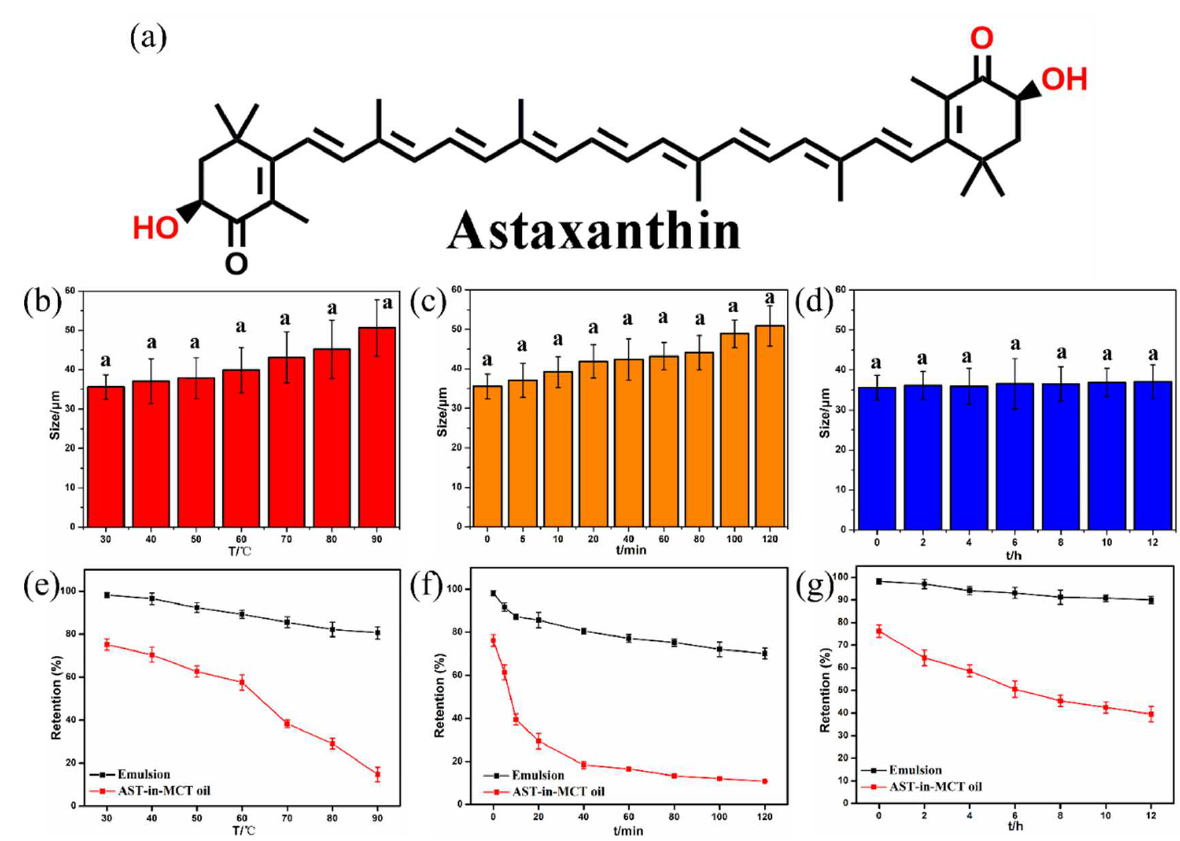
Figure 7. Chemical structure of AST ( a ). Changes in droplets size and AST retention amount of OS/β-lg complex stabilized emulsions facing thermal treatment ( b , e ), oxidative stress ( c , f ), and ultraviolet irradiation ( d , g ). Bars with different letter superscripts are significantly different at p < 0.05.